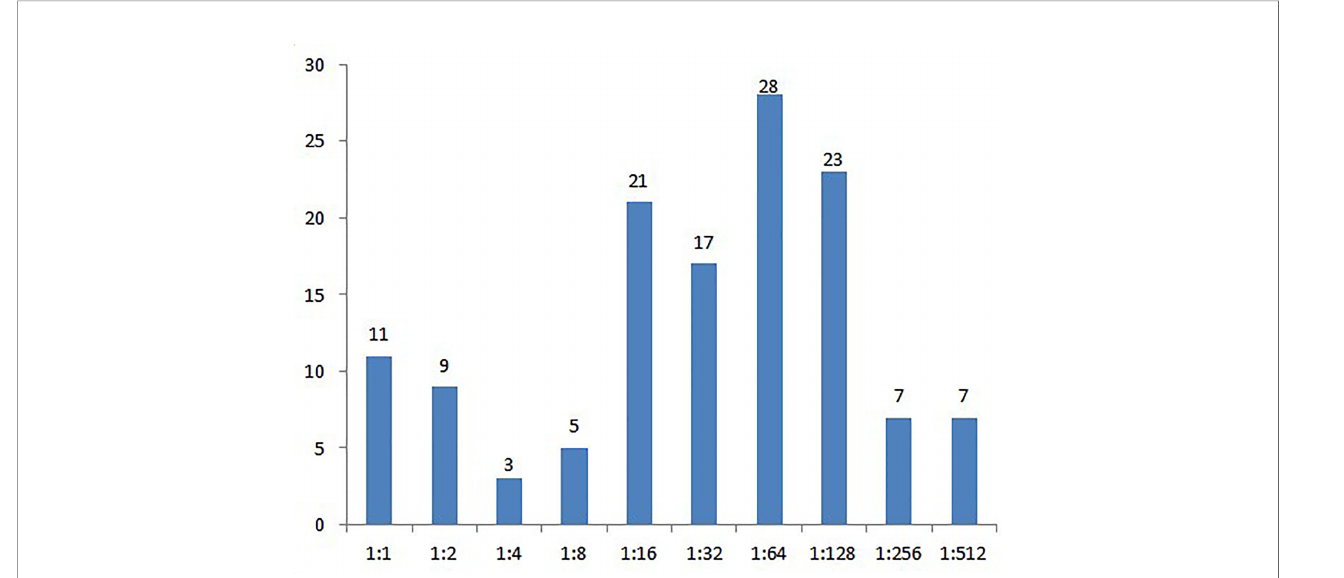
FIGURE 5 | Rapid plasma regain titers of cases with ocular syphilis at presentation.